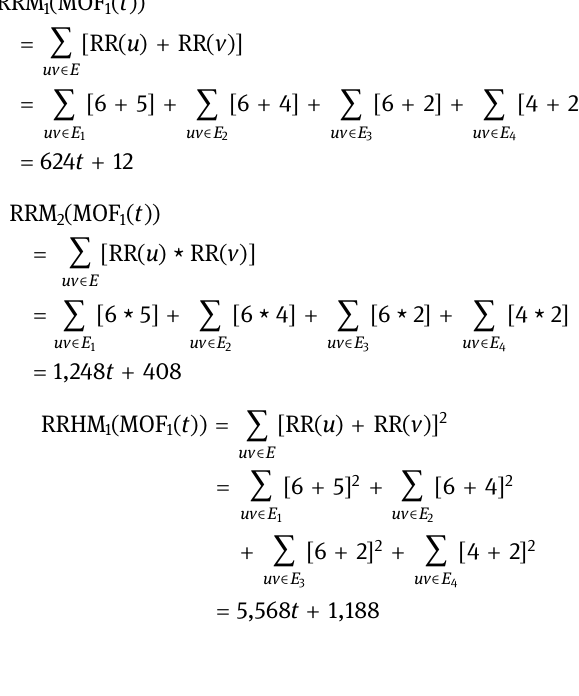
Table 2: Reduced degree edge partitions of MOF 2 ( t